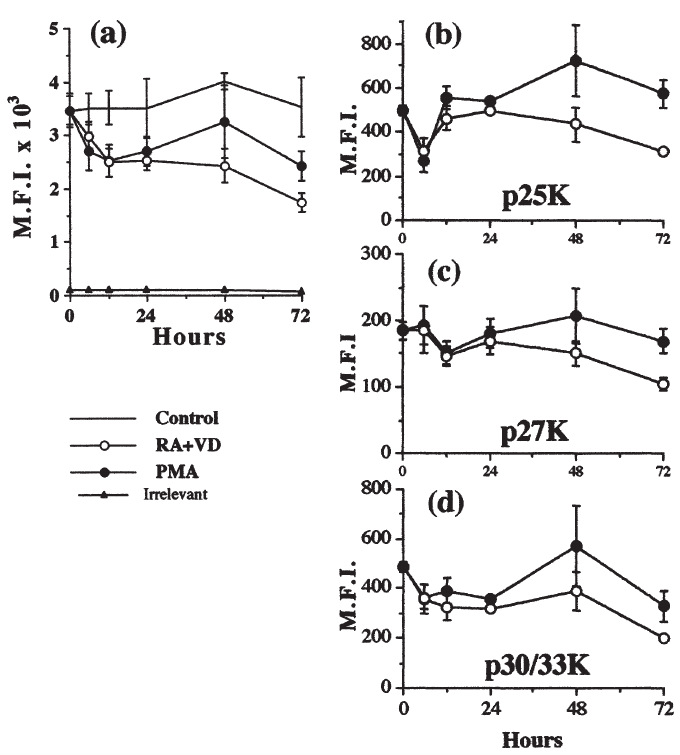
Fig. 3. (a) Flow cytometric detection of proteasomal proteins on control and induced U937 cells. For each time-point, the cells were permeated by incubation for 30 min in cold 70% ethanol and incubated with a panel of 7 monoclonal antibodies. GAM-FITC was used as conjugated secondary antibody. MFI of 10,000 cells was determined by flow cytometry (FACScan, Becton-Dickinson, Mountain View, USA). Each point on the curves is the mean MFI ± SEM of at least three different experiments. Non-specific immunoreaction was low (MFI of 90 . 47 ± 3 . 22, data not shown), as determined with irrelevant total mouse immunoglobulins. Flow cytometric detection by monoclonal antibodies anti-p25K (b), anti-p27K (c) and anti-p30/33K (d) of proteasomal protein subunits on RA+VD and PMA-induced U937 cells. The proteasomal protein subunit contents of non-induced control cells remained constant throughout the 72 h period of experiment (see T =